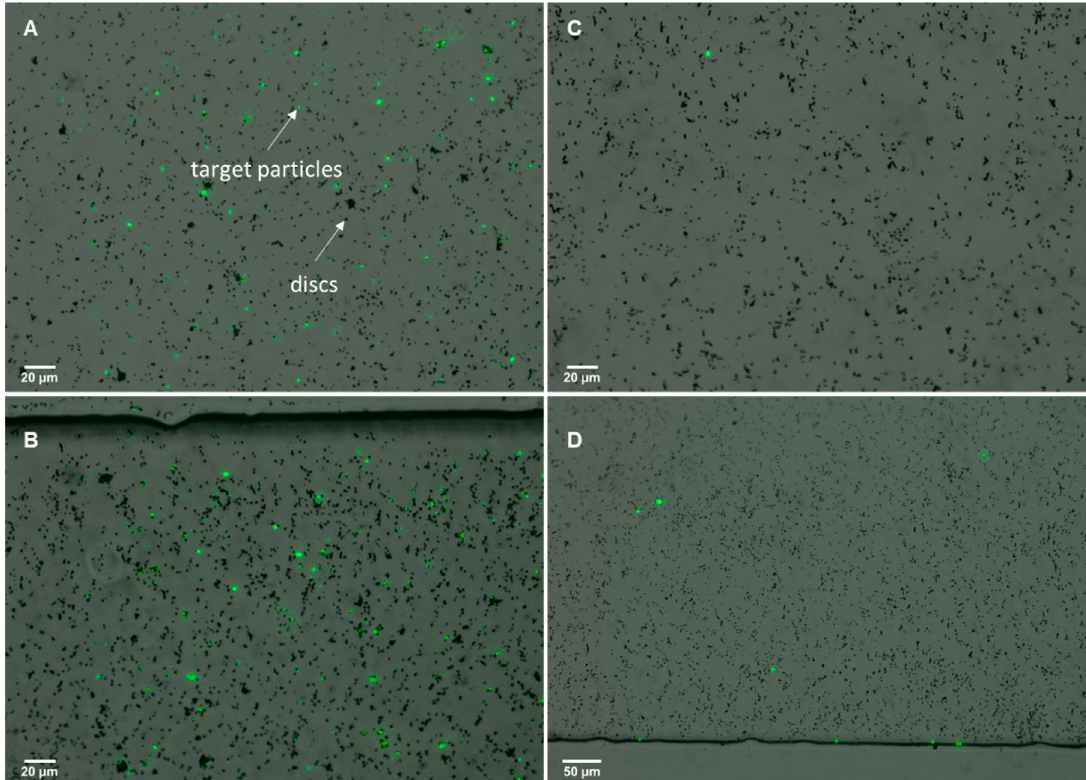
Figure 8. Isolation of fluorescent avidin coated (target) particles from 100 mL samples using biotin-functionalized magnetic microdiscs. ( A , B ) 100 mL sample containing 3000 million particles and ( C , D ) 100 mL sample containing 3000 particles.